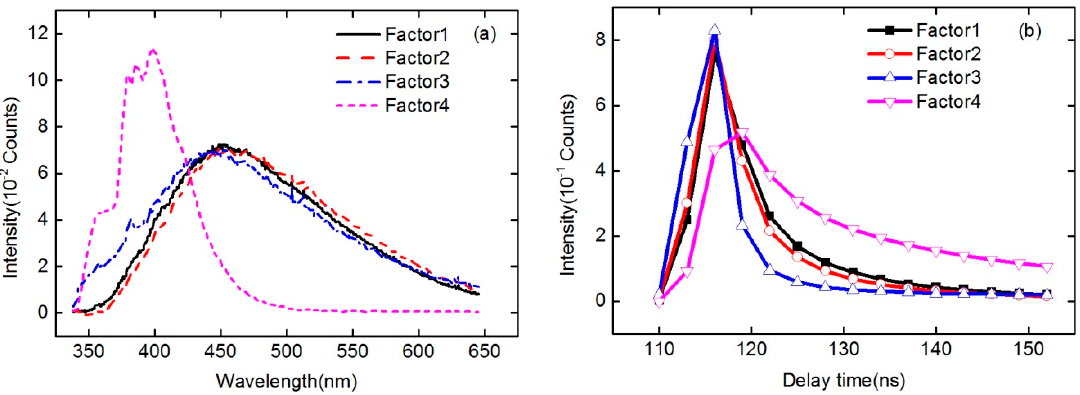
Figure 9. Intensities of the decomposed factors ( F = 4) of PARAFAC as a function of emission wavelength ( a ) and delay time ( b ), respectively.